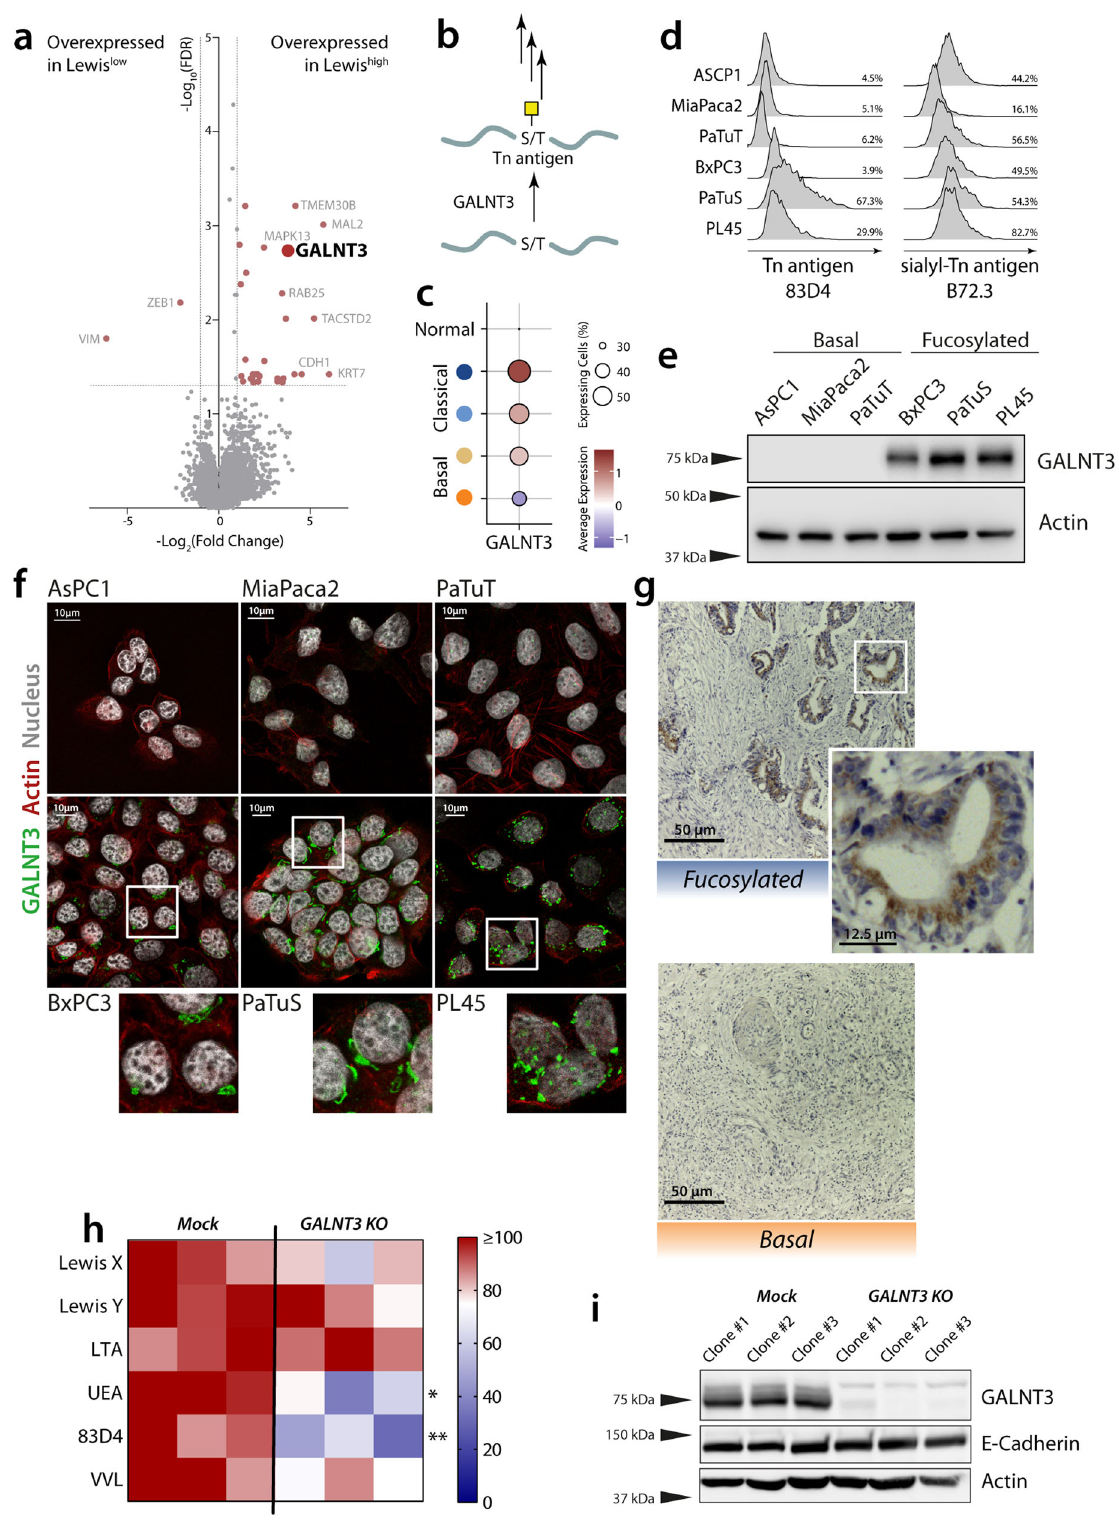
Fig. 5 GALNT3 is overexpressed in Fucosylated cell lines and contributes to its glyco-phenotype. a Volcano plot of a differential gene expressed genes between the Lewis high and Lewis low cell lines de fi ned in. b Scheme of the GALNT3 enzymatic activity. c Expression of GALNT3 in the different tumour clusters in scRNA-seq. d Expression of Tn antigen (mAb: 83D4) and Sialyl-Tn antigen (mAb: B72.3) was analyzed by fl ow cytometry. e Western blot of GALNT3 in selected PDAC cell lines. f Confocal microscopy of GALNT3 (green) and actin (red). g Expression of GALNT3 is associated with the Fucosylated subtype in PDAC tissue. h Analysis of the expression of glycan structures using plant lectins and antibodies by fl ow cytometry in WT and GALNT3 KO cell lines. Statistical analysis: Two-way ANOVA with Sidak method for multiple test correction (* p ≤ 0.05; ** p ≤ 0.01; *** p ≤ 0.001). i Western Blot of GALNT3, E-Cadherin and Actin in WT and GALNT3 KO cell